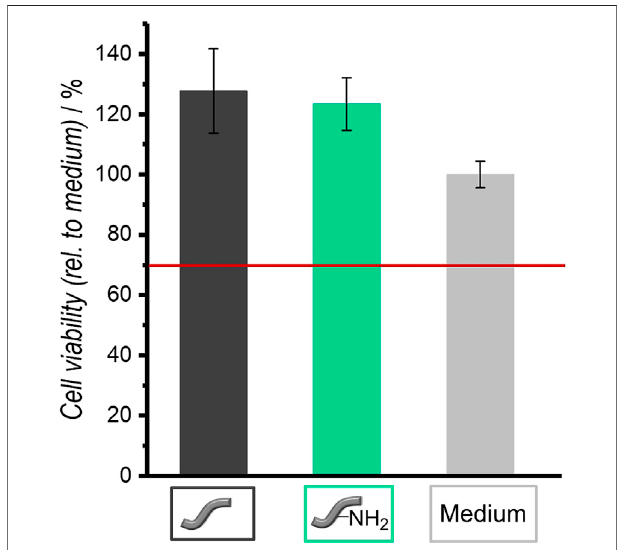
FIGURE 11 | Relative cell viabilities of NIH 3T3 fi broblasts in the presence ofunmodi fi ed and amino-modi fi ed fi bers asdetermined by the NRU assayafteranincubationof4 days.Valuesaregivenasmean ± standarderror of the mean ( N (cid:1)